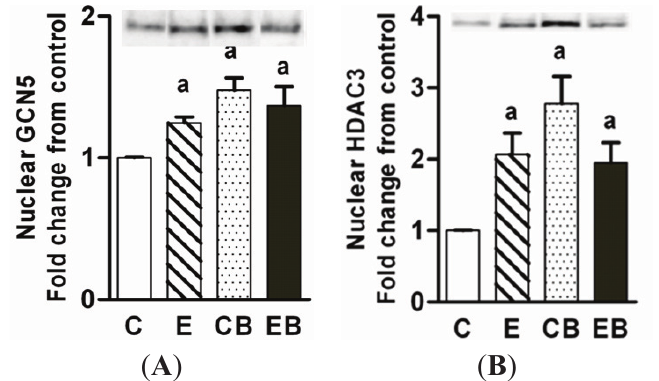
Figure 6. Levels of GCN5 ( A ); and HDAC 3 ( B ) in chronic ethanol-binge treated mice. The experimental protocol were as in the “Experimental Section”. The levels of GCN5 and HDAC3 were determined by western blotting and the representative images of blots are shown above the histograms. Values are mean ± SE ( n = 4 mice). a: significant compared to control ( p < 0.05). C: Control (pair fed); E: Chronic ethanol; CB: Control ethanol